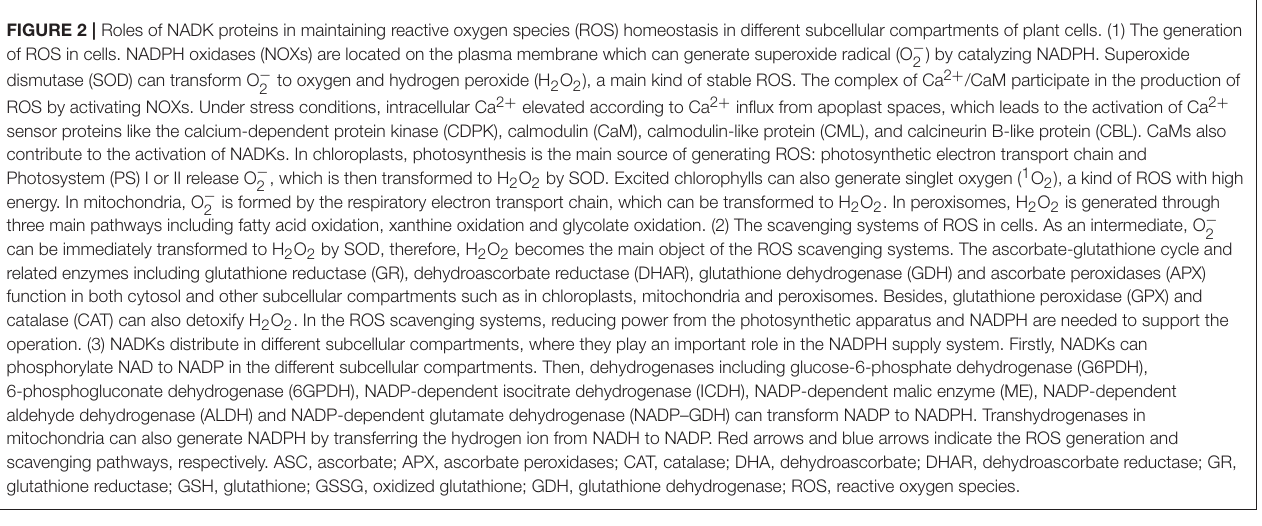
Frontiers in Plant Science |